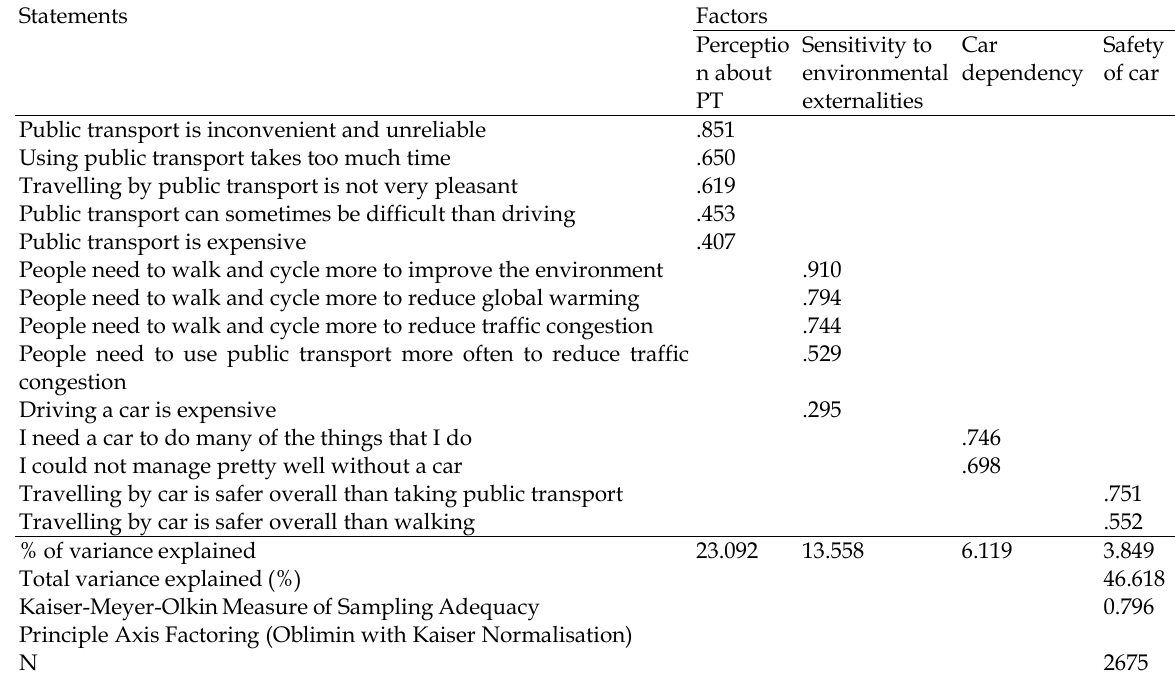
Table 1. Pattern matrix showing variable loadings on travel attitude factors in 2009